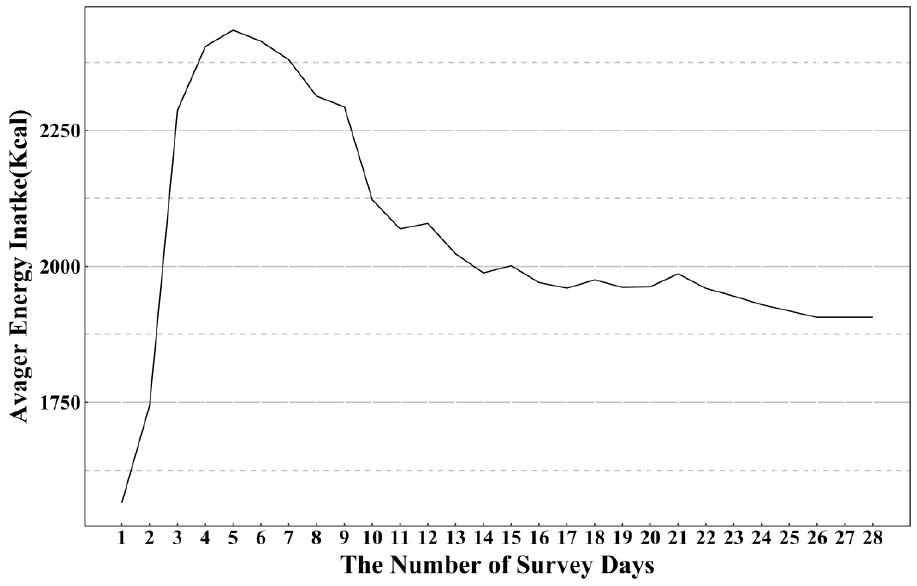
Figure 1. L ine graph of an individual’s average energy intake versus the number of survey